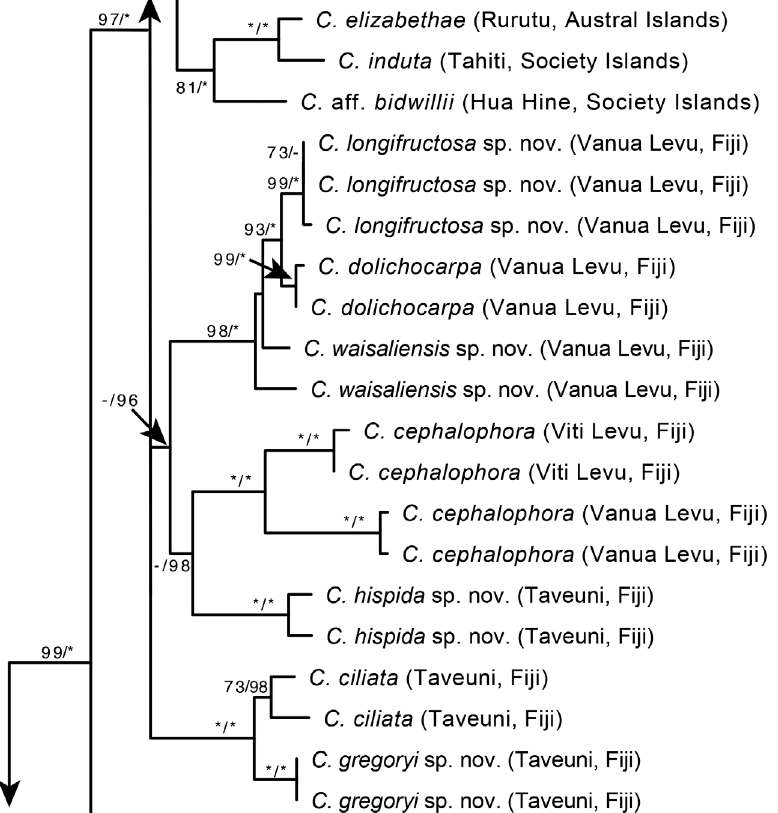
Figure 4. A portion of the Maximum Likelihood phylogram from Johnson et al. (2017) based on three nuclear (ITS, ETS, Cyrt 1) and two chloroplast ( psb A- trn H, rpl 32- trn L) loci. Support values shown for each branch are bootstrap and posterior probabilities when ≥ 50% and ≥ 0.50, respectively. An asterisk indicates 100% BS or 1.0 PP; a dash indicates that the branch was not